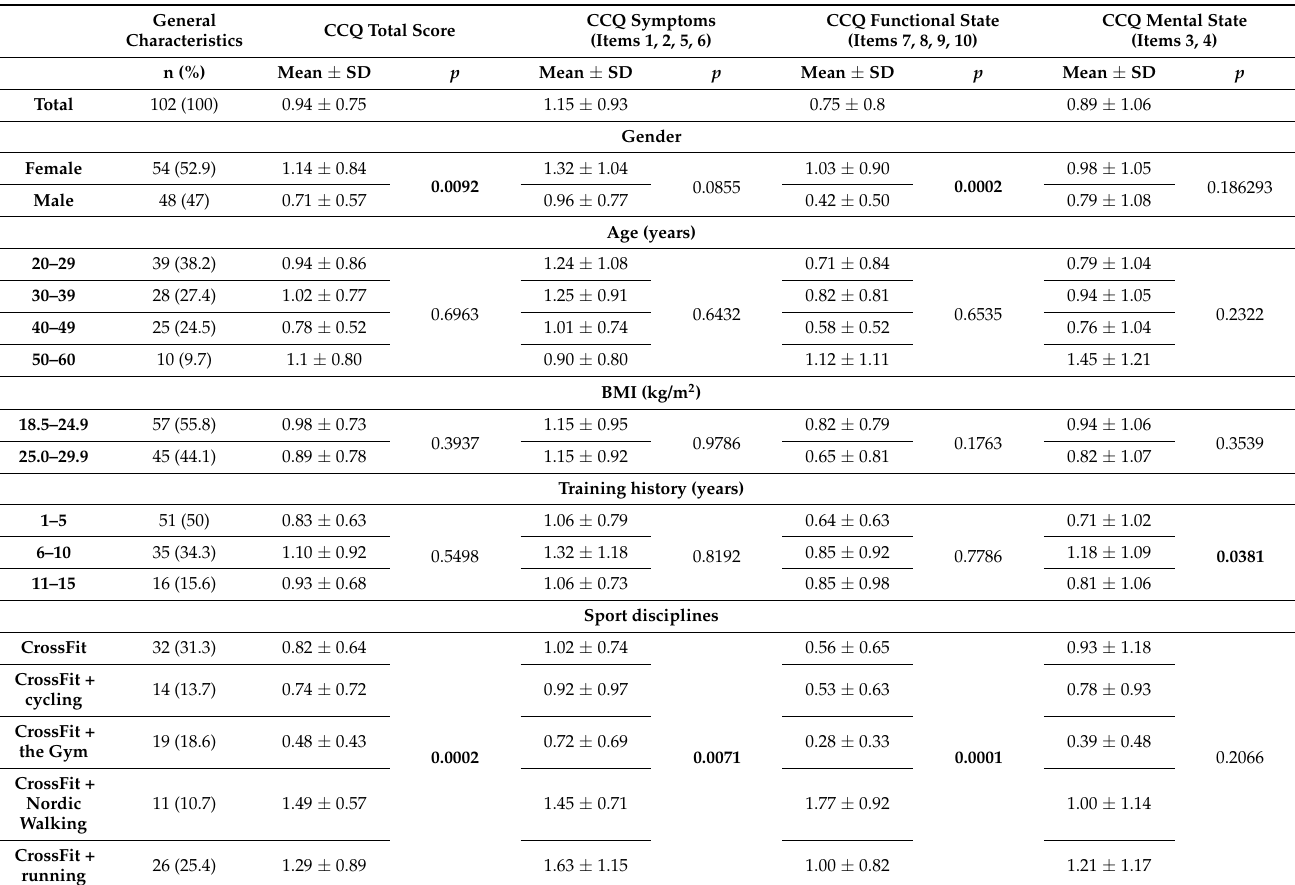
Table 2. CCQ Total score and three domains analysis results: CCQ Symptoms, CCQ Functional state and CCQ Mental state outcomes with statistical